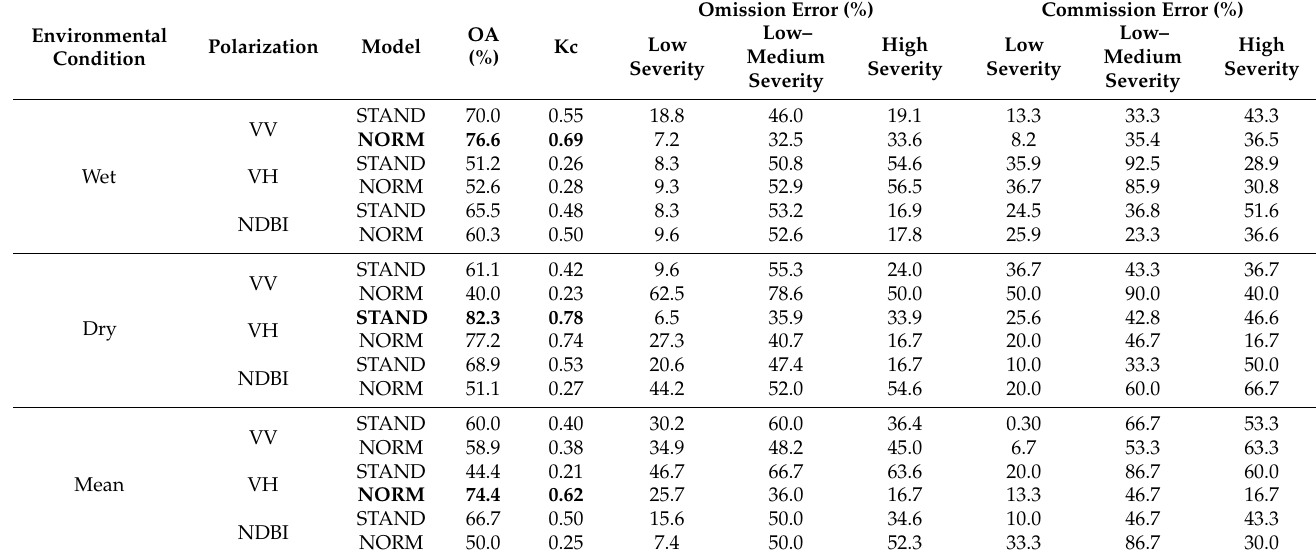
Table 2. Validation results for severity estimates under different environmental conditions obtained for the VH polarization. Environmental